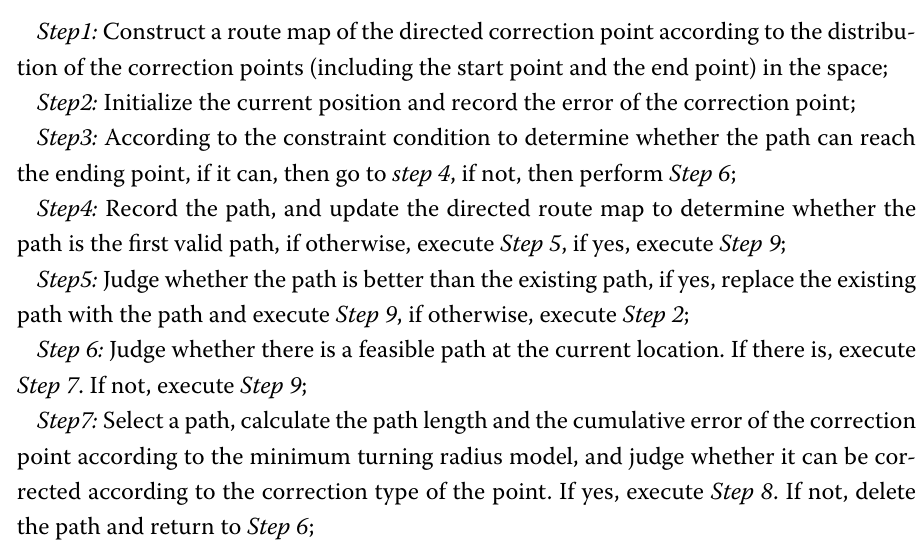
Table 2 Position and correction type of 5 randomly selected points Calibration point number